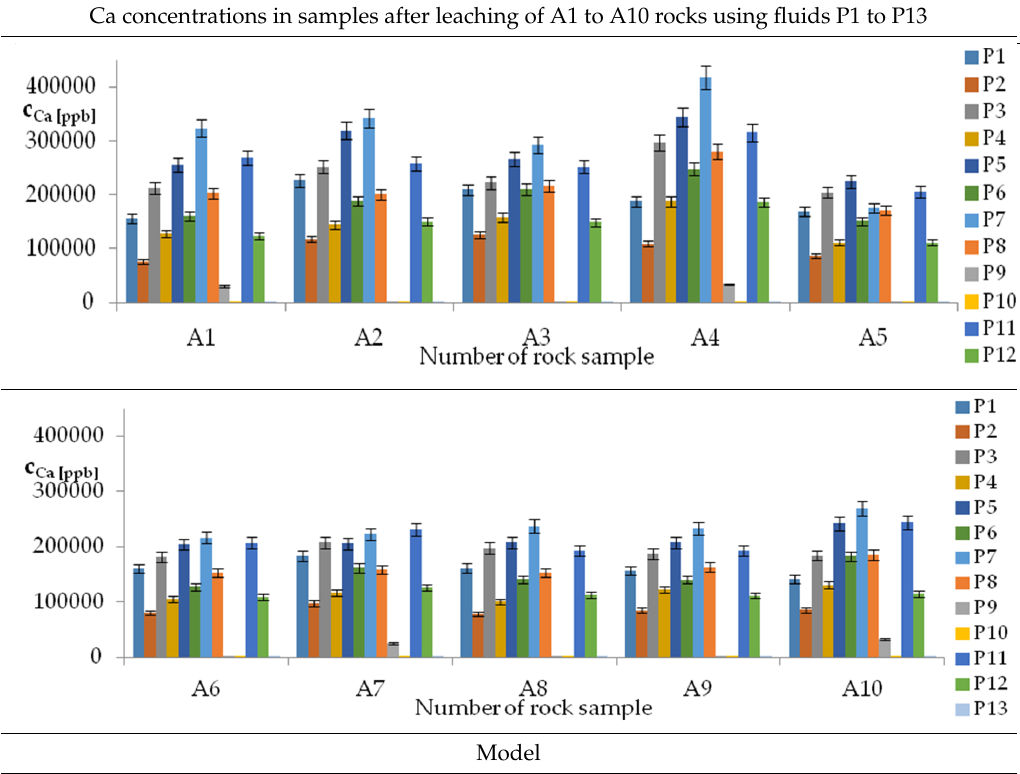
Table 11. Results of leaching samples A1 to A10 rocks using fluids P1 to P13 for Calcium (Ca). Ca concentrations in samples after leaching of A1 to A10 rocks using fluids P1 to P13